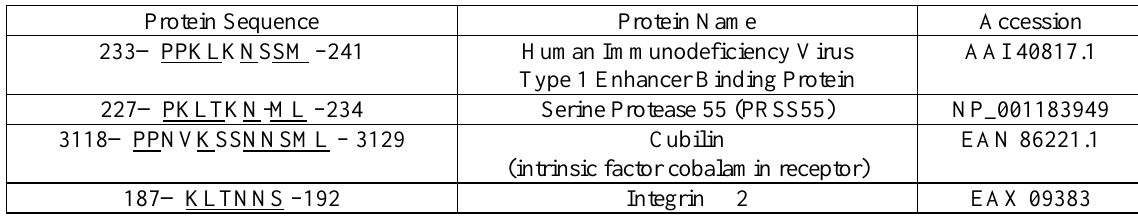
Table 2. Identified sequence homologies to the QFPPKLTNNSML peptide obtained by searching the non-redundant ( nr) NCBI protein database performing local sequence alignment. The underlined amino acids correspond to exact alignment of the protein sequences with the new peptide. The numbering on both ends of the sequences indicates the region where homology